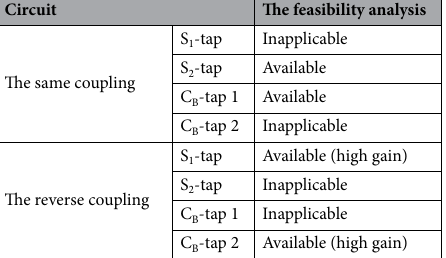
Table 2. The feasibility analysis of the topologies’ large ratio.